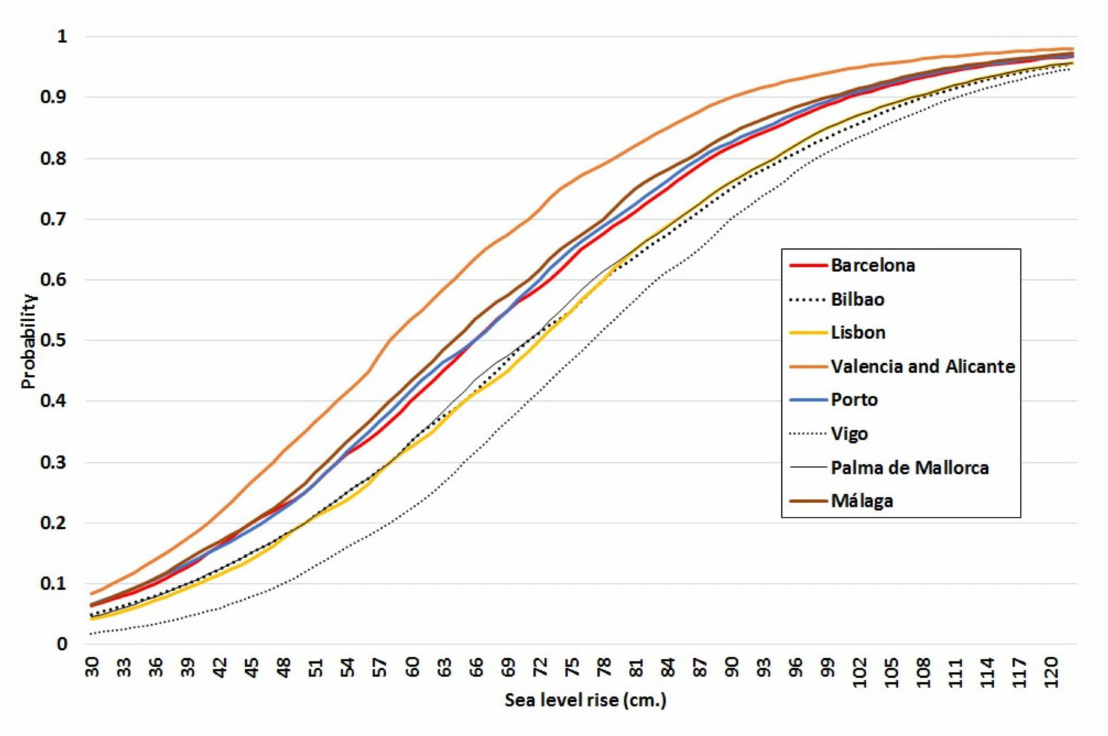
Figure 3. Cumulative distribution function of sea-level rise in 2100 for the nine Iberian cities with largest population under emission scenario RCP 8.5.